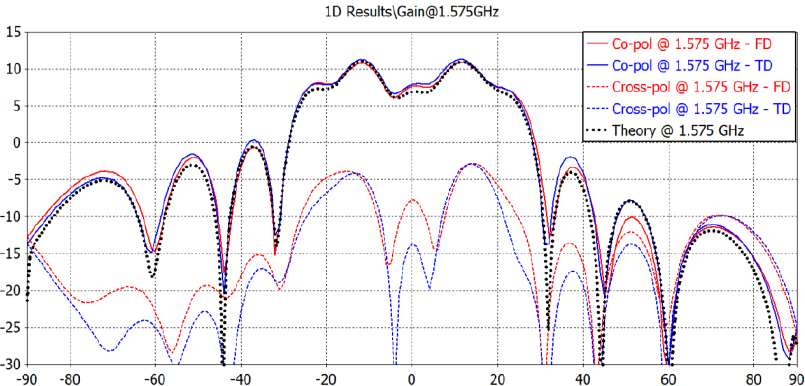
Figure 12. Design 1 – 8-element patch array: simulated gain at 1.575 GHz.